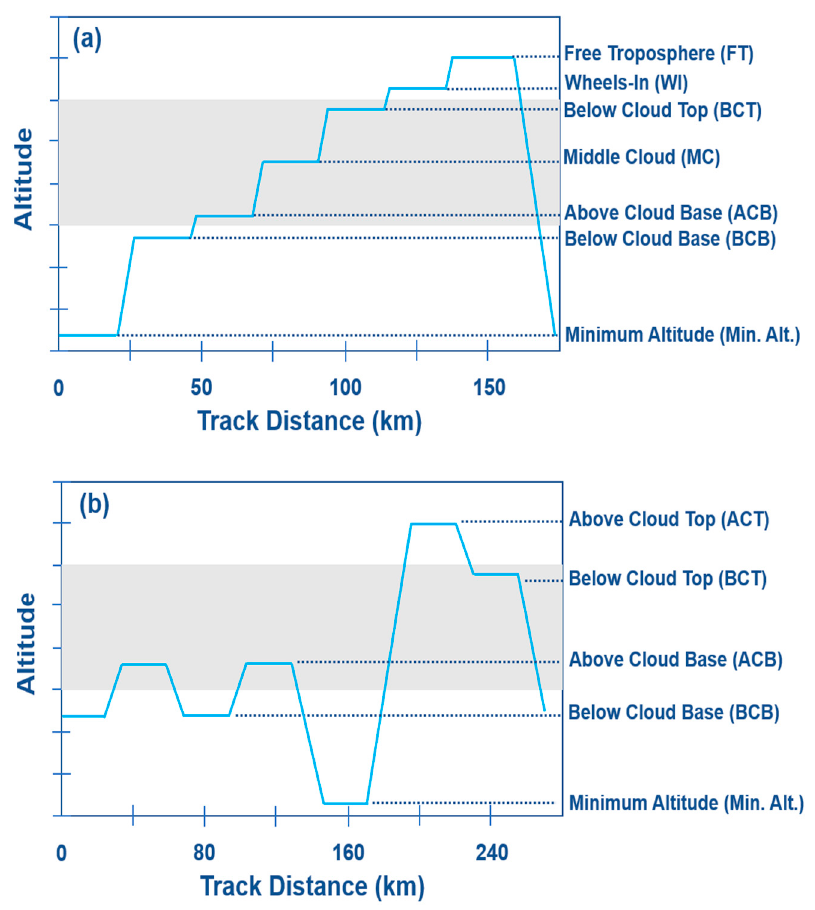
Figure 2. Typical flight path conducted during cloud ensembles of ( a ) MONARC 2019 and ( b ) 2020 ACTIVATE research flights, with gray shading representing a cloud layer. Clear ensembles including a Min. Alt. leg followed by below boundary layer top (BBL) and above boundary layer top (ABL) legs and then a slant descent back to Min. Alt.